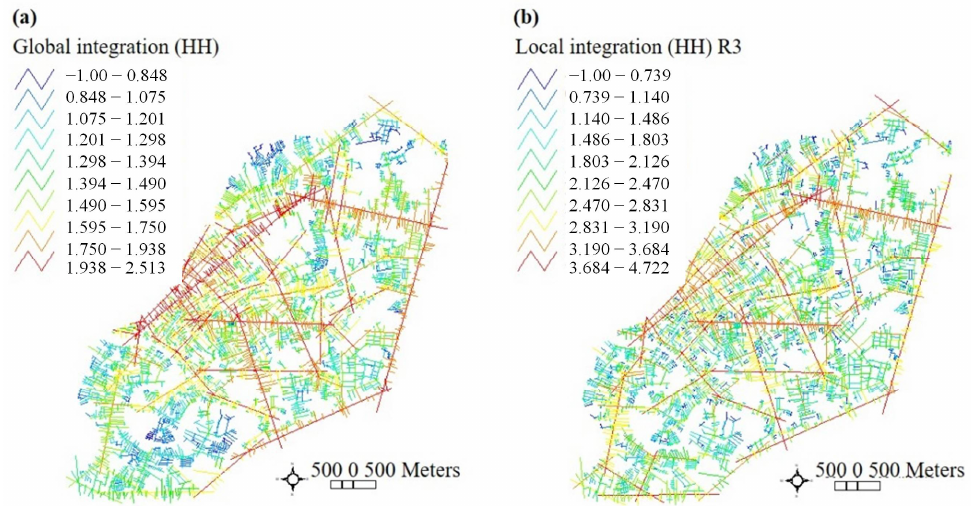
Figure 6. The space syntax model analysis results: ( a ) global integration value and ( b ) local integration value. Table 1. Mean values and standard deviations (SD, in parentheses) of space syntax for the study area. Space Syntax